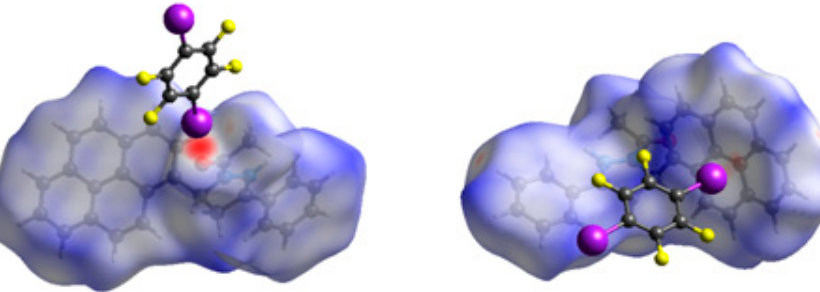
Figure 6. Hirshfeld surface mapped with d norm for the cocrystal.